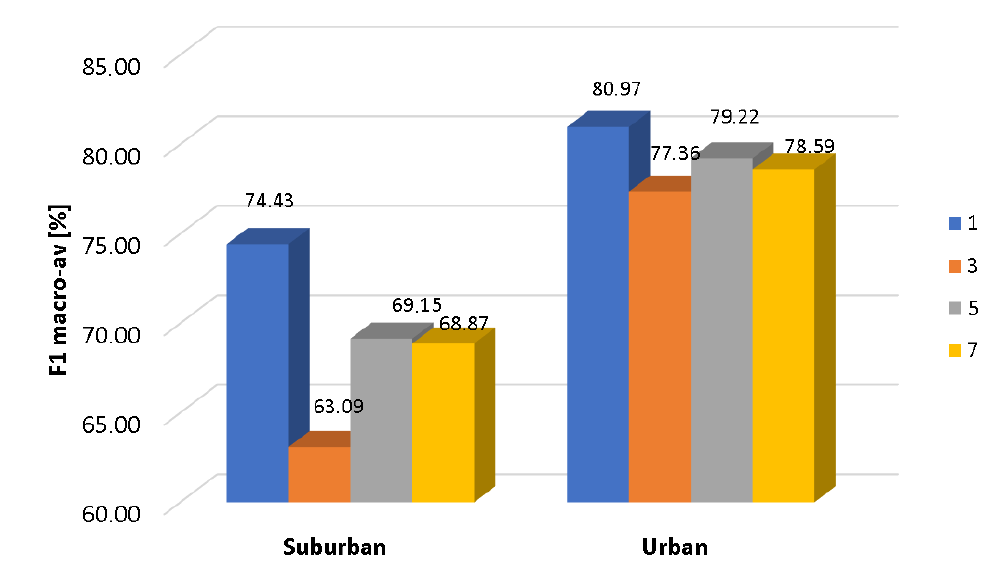
Figure A2. KNN optimization results using the real-life suburban and urban databases, respectively. A different value of the number of neighbors K has been used for each experiment (see the figure